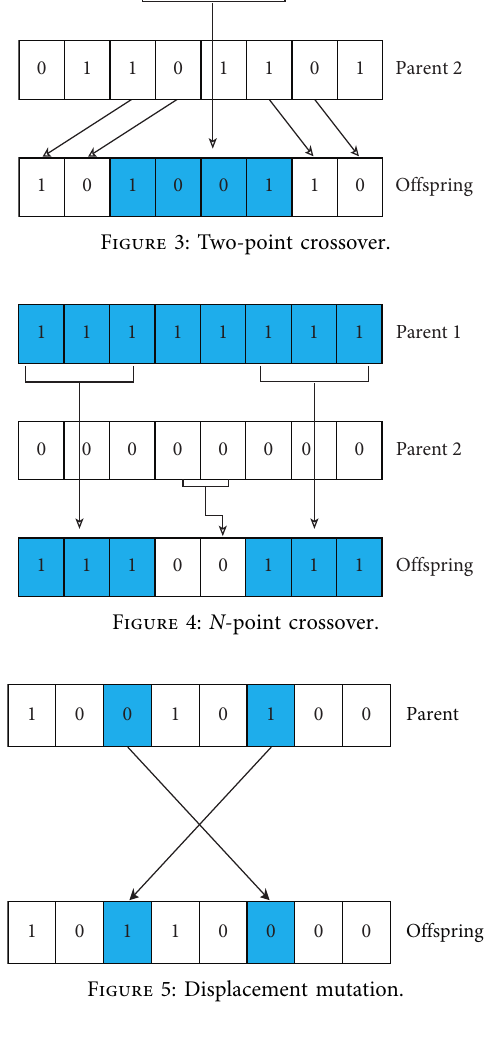
Figure 5: Displacement